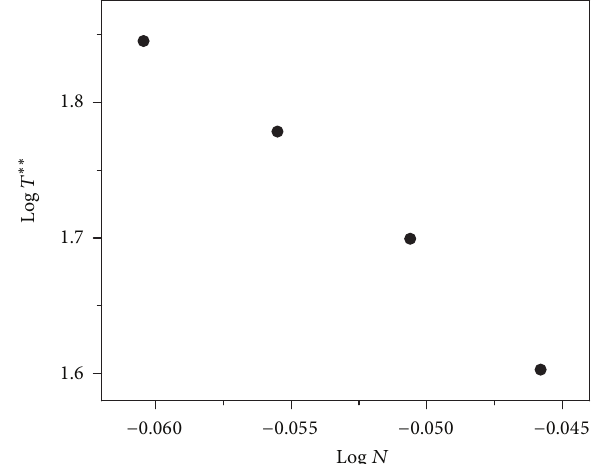
Figure 4: 𝑇 ∗∗ is plotted as a function of 𝑁 , 𝑃 = 0.05 , 𝑊 = 1 .